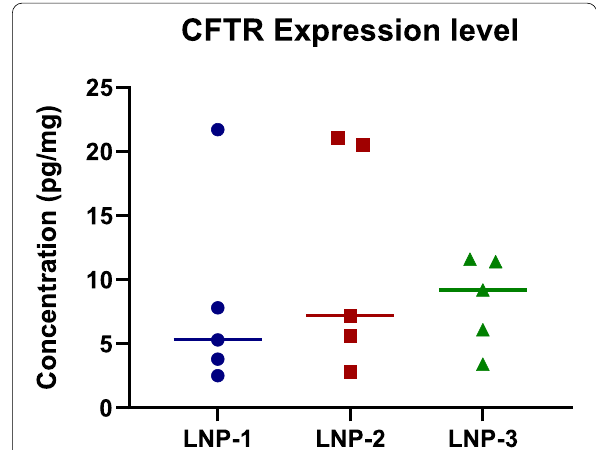
Fig. 7 hCFTR level measured by the developed method in mouse lung treated with three different LNPs formulations. 50 mg of mouse lung tissue was analyzed. Five animals were dosed for testing each formulation. Streptavidin magnetic beads and biotinylated anti-CFTR antibody were used for IP. Absolute quantification of hCFTR protein was based on the calibration curve of CFTR peptide